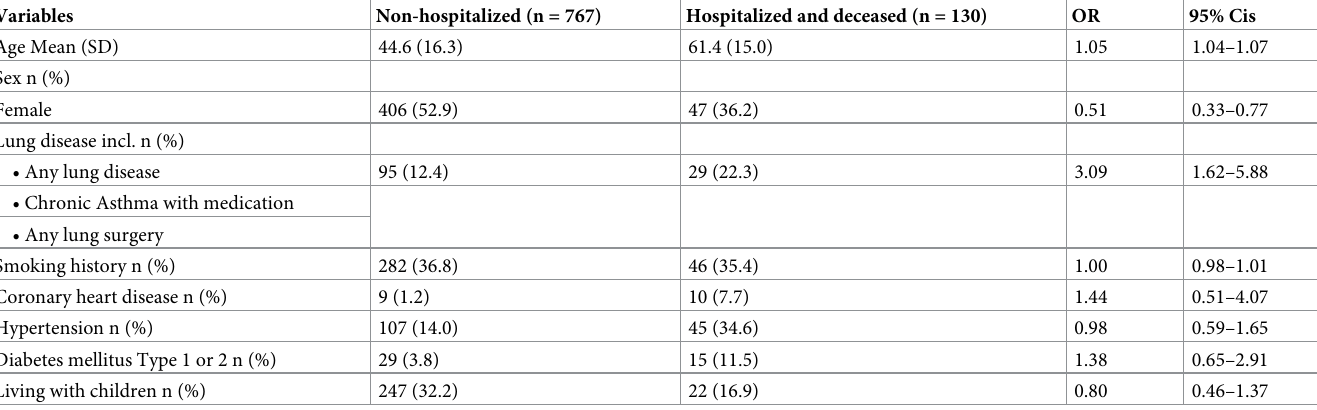
Table 3. Risk factors associated with hospital admission.